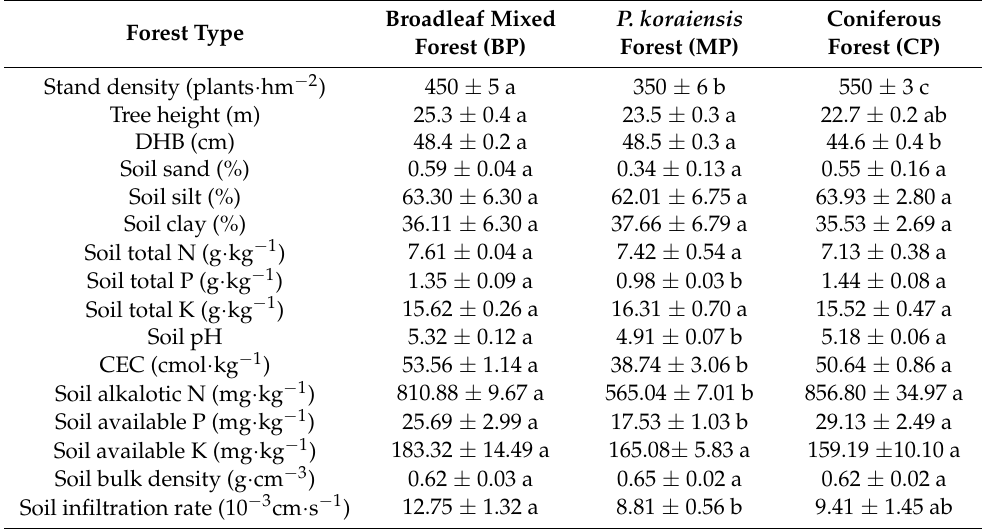
Table 1. The basic stand situation and soil properties in three forest